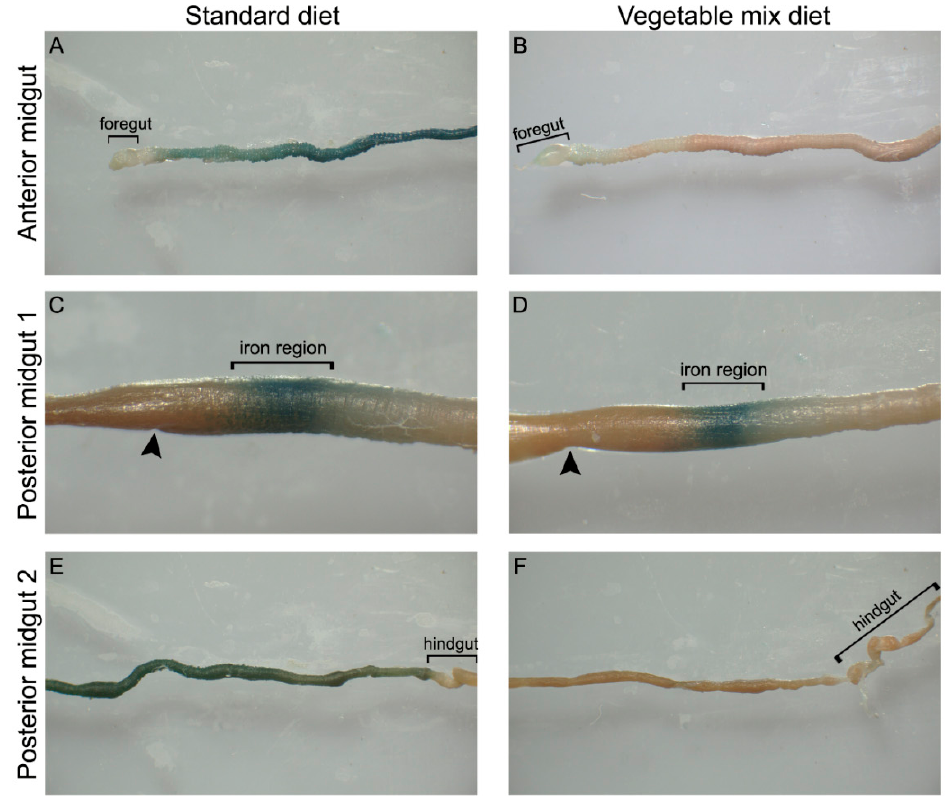
Figure 5. Comparison of iron accumulation between the three midgut regions of larvae reared on SD and VMD—Perls’ method. ( A , B ): a higher iron accumulation in the anterior midgut of larvae reared on SD ( A ) compared to VMD ( B ) can be observed. ( C , D ): iron region in the first part of the posterior midgut of larvae reared on the two diets. ( E , F ): higher accumulation of iron in the second part of the posterior midgut of larvae grown on SD than VMD is visible. Arrowheads: transition zone between middle and posterior midgut.